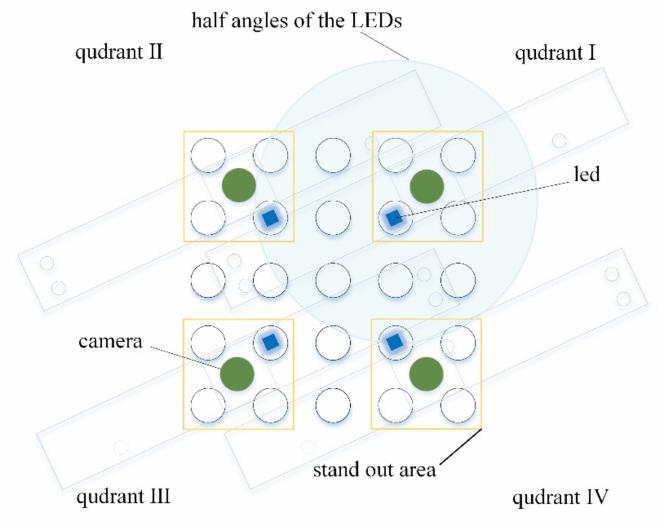
Figure 3. Quadrant of all 5 × 5 wells: camera and LED